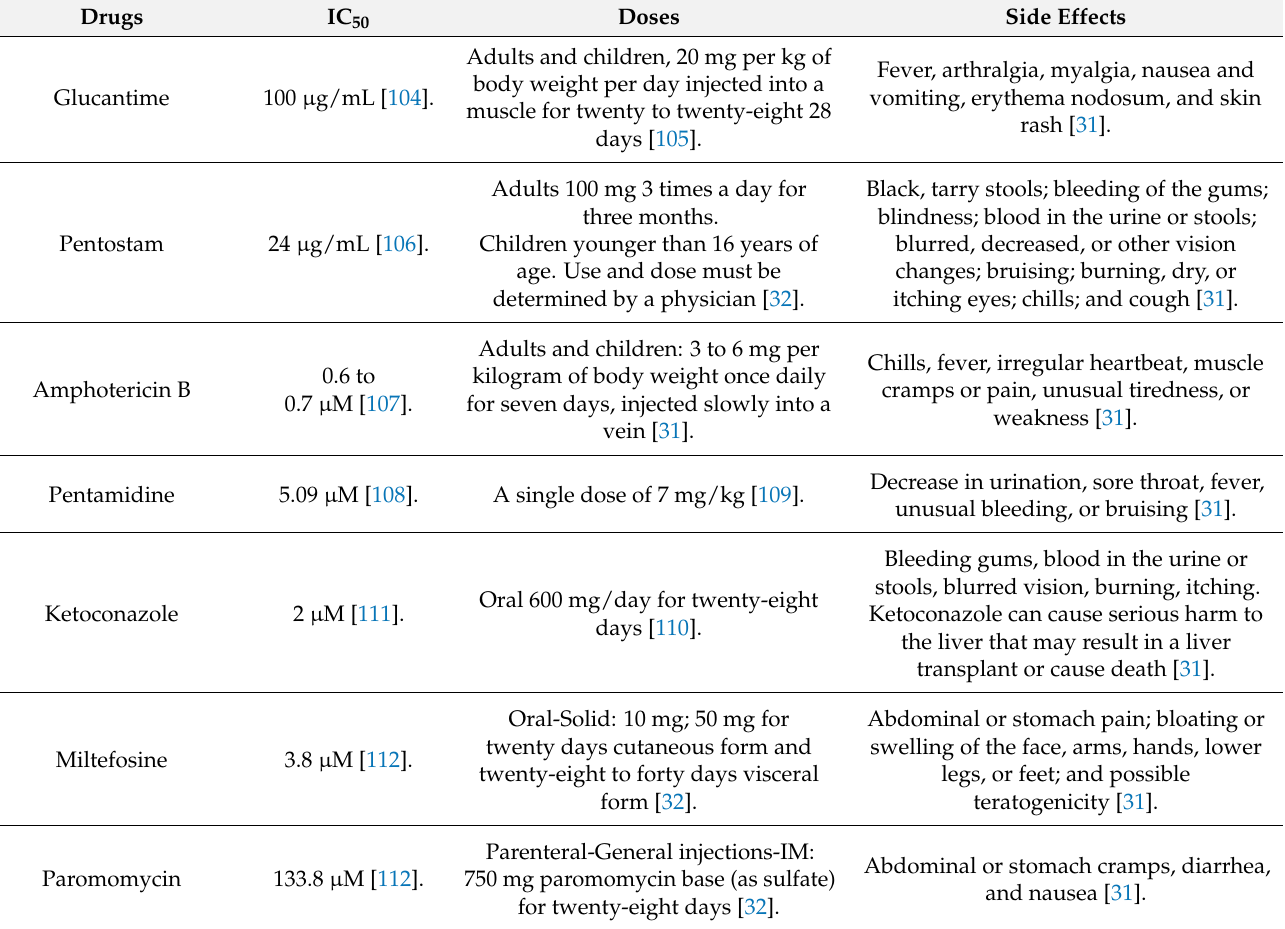
Table 3. Biological activity, dose, and adverse effects of drugs used against